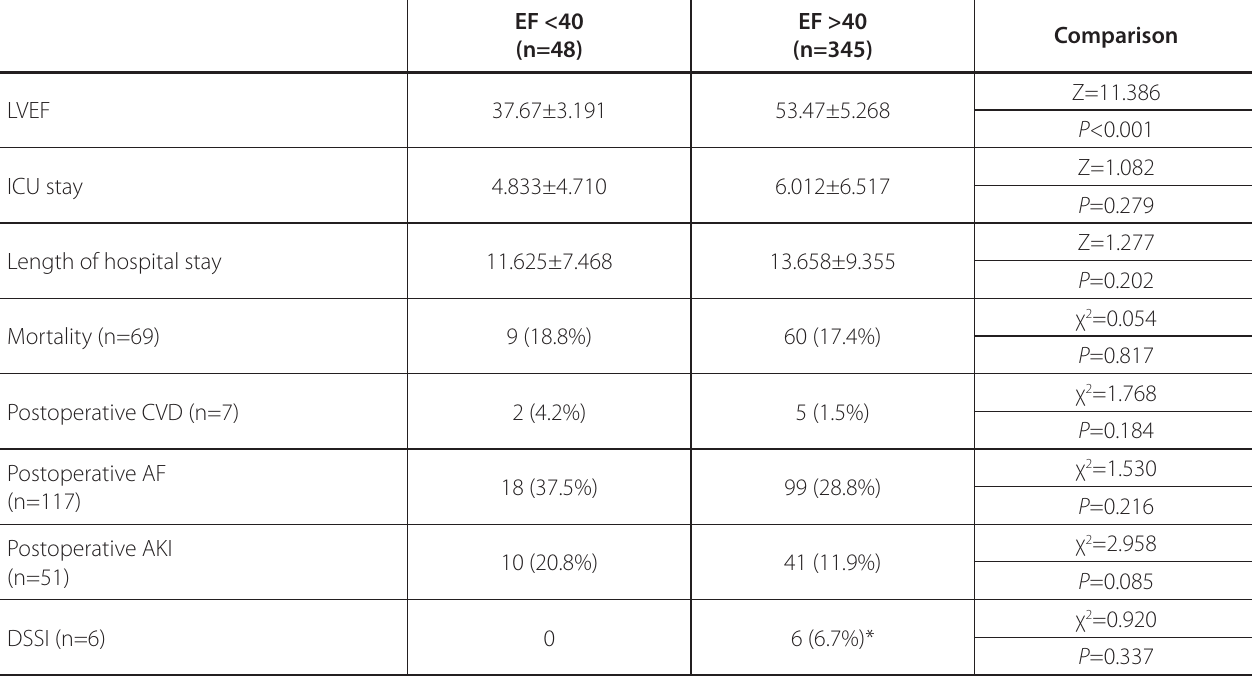
Table 2 . Evaluation of patients according to LVEF